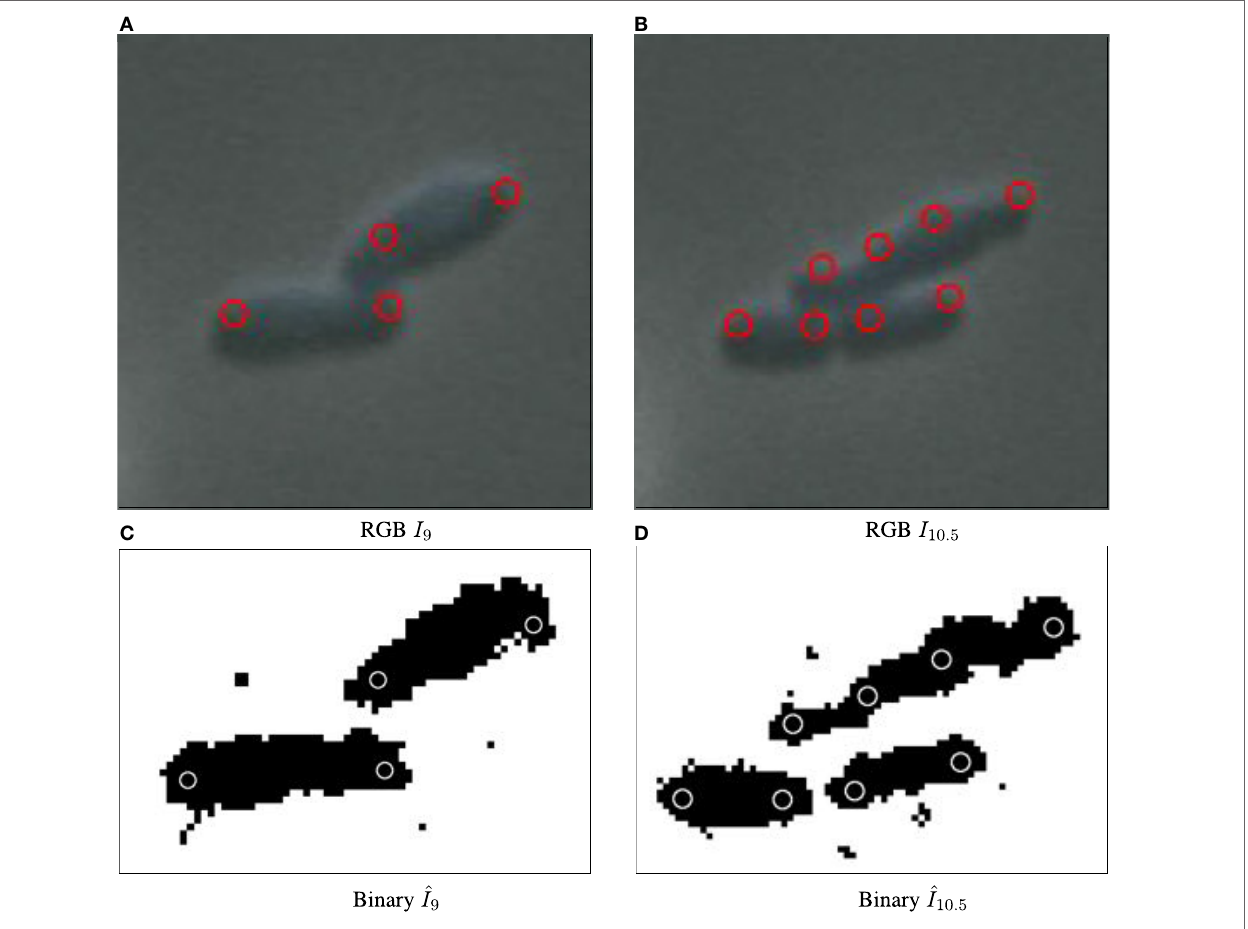
Figure 5 | Particle detection for biomovie D1 across cell division events, with detected particle locations annotated as red circles on original images (a–B) and white circles on binary images (c,D) . The particle paradigm copes with cell division despite high levels of noise, and the direct contacts between cells: when the cell elongates, a new particle is created in the center when the width between the previous particles surpasses the distance